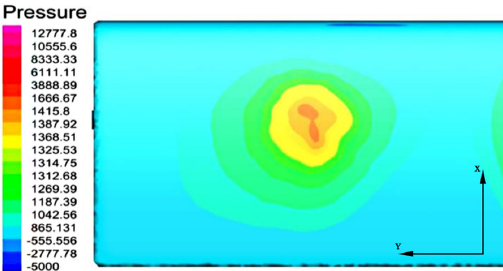
Figure 22. Download pressure nephogram of wing surface.